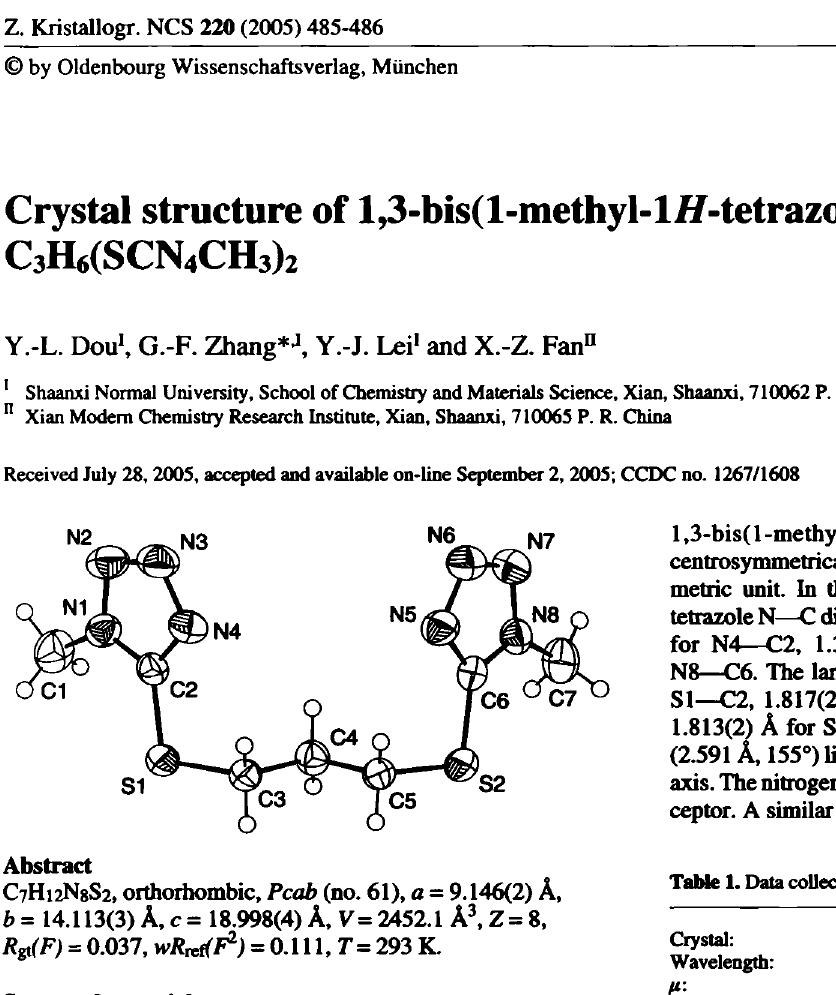
Table 1. Data collection and handling.